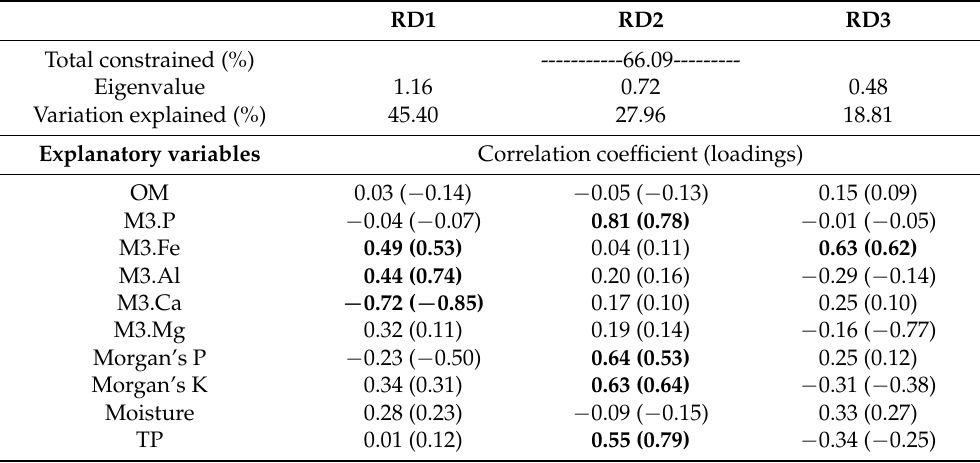
Figure 1. Soil phosphorus (P) fractions, expressed as proportion of soil total P, across grassland soils, as categorised by P index for grassland—P index 1 (0–3 mg P L − 1 ), P index 2 (3.1–5 mg P L -1 ), P index 3 (5.1–8 mg P L -1 ) and P index 4 (above 8 mg P L -1 ). Table 3. Percentage of constrained and unconstrained variance in the redundancy detrended analysis (RDA). Numbers in brackets correspond to the RDA loadings. Bold numbers represent a significant ( p < 0.05) correlation coefficient